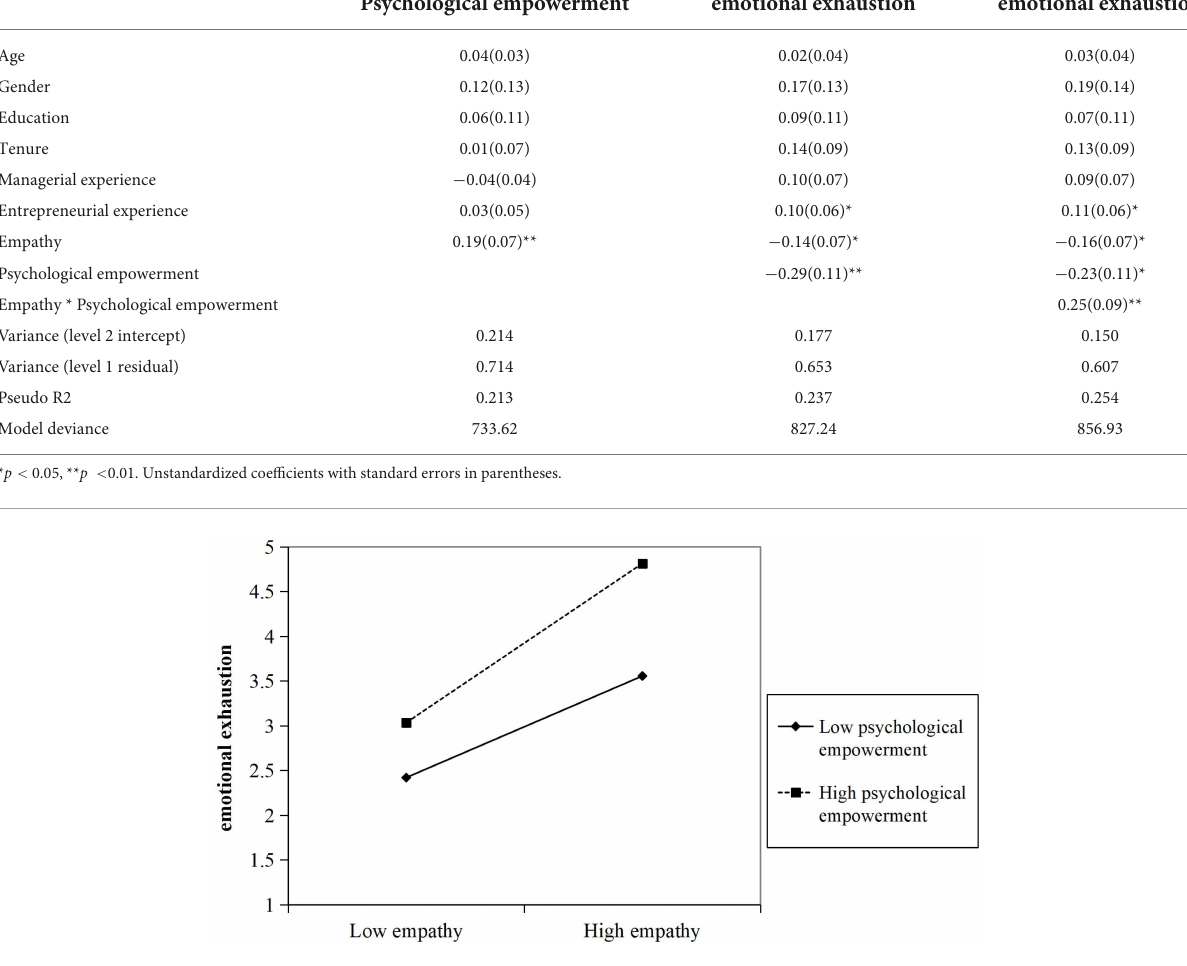
FIGURE2 Two-way interaction